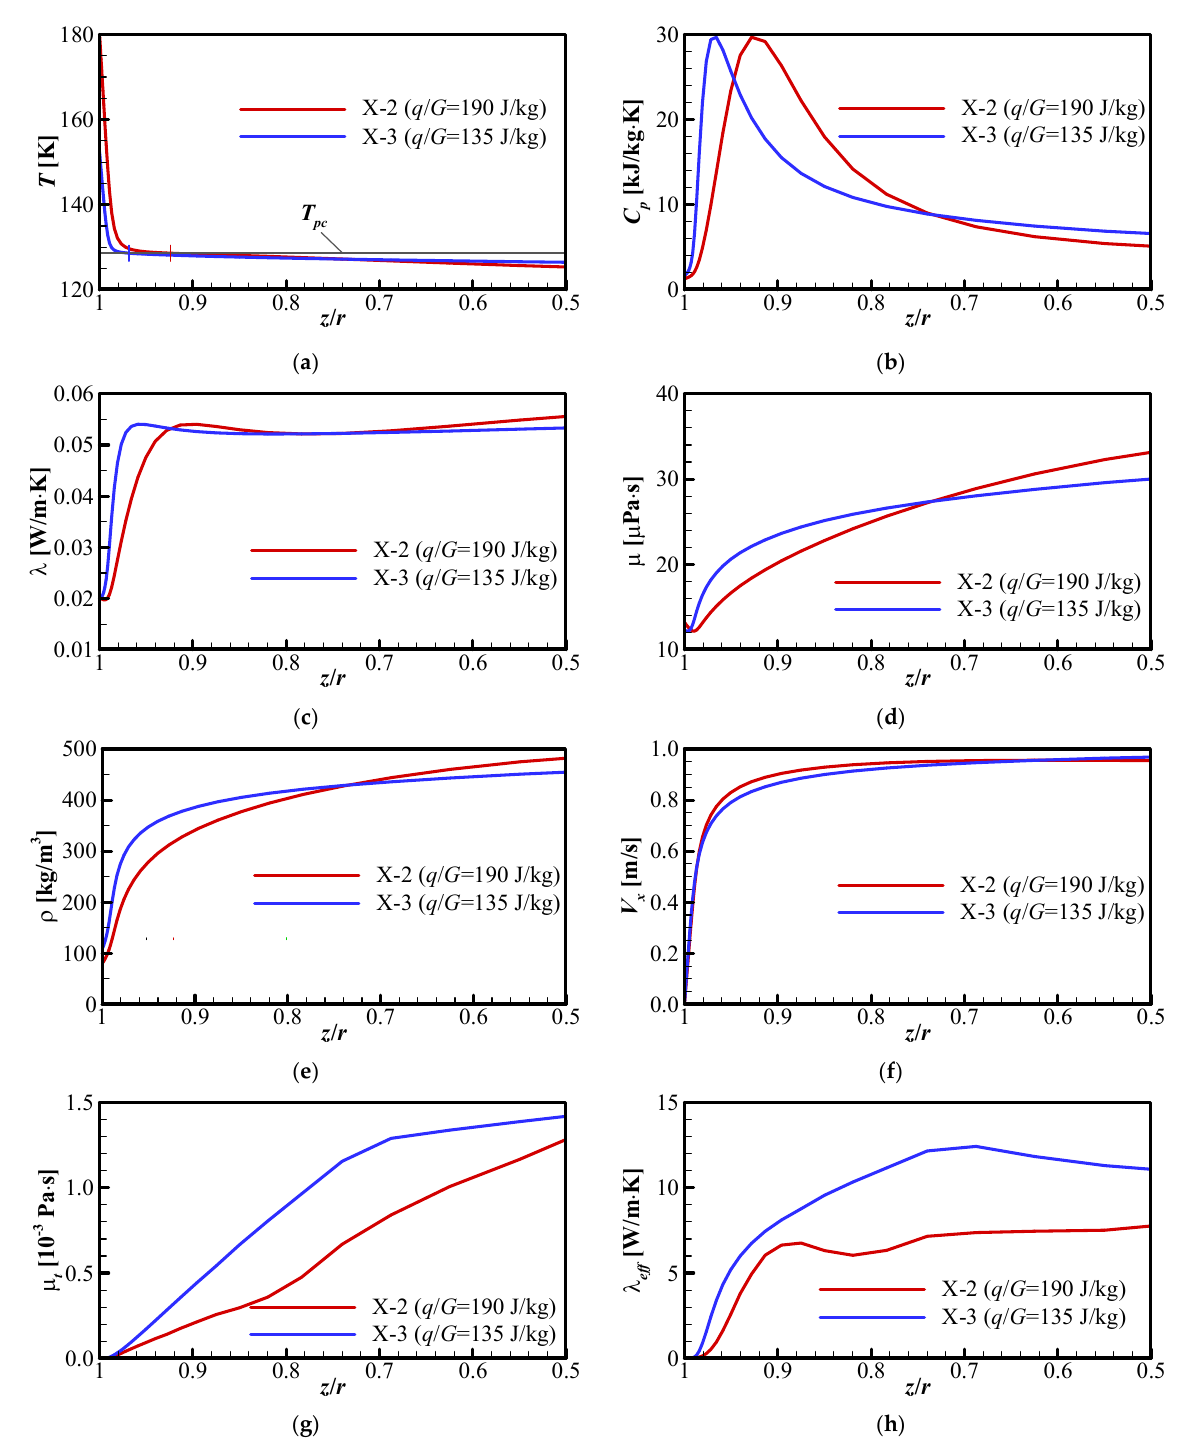
Figure 12. Radial variations at four different axial locations for the case with q / G = 190 J/kg at p = 3.8 MPa and G = 385 kg/m 2 · s: ( a ) temperature; ( b ) specific heat; ( c ) thermal conductivity; ( d ) viscosity; ( e ) density; ( f ) axial velocity; ( g ) turbulent viscosity; and ( h ) effective thermal conductivity. z / r = 1 and 0 denote the wall and centreline of the tube,